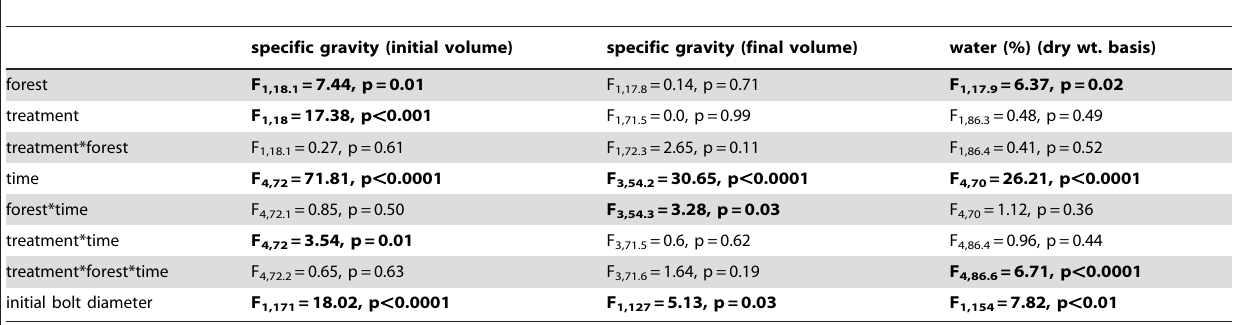
Table 1. Comparisons of response variables between forest types (flooded vs. unflooded), treatments (protected vs. unprotected) and over time (6, 12, 18, 24, and 31